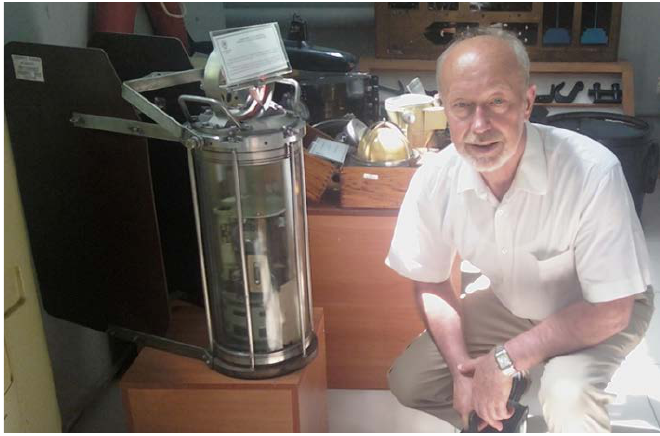
Fig. 2 Strong cylindrical shell of underwater oceanographic device made of glass